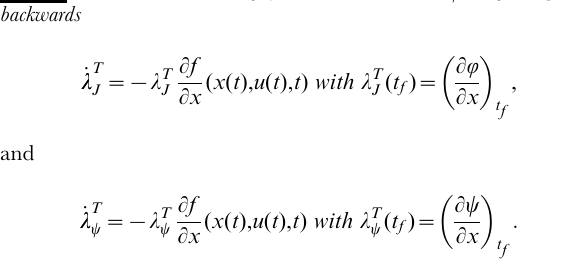
Figure S2 Polar phase-amplitude resetting maps corre- sponding to figure 3. Circadian phase is plotted in